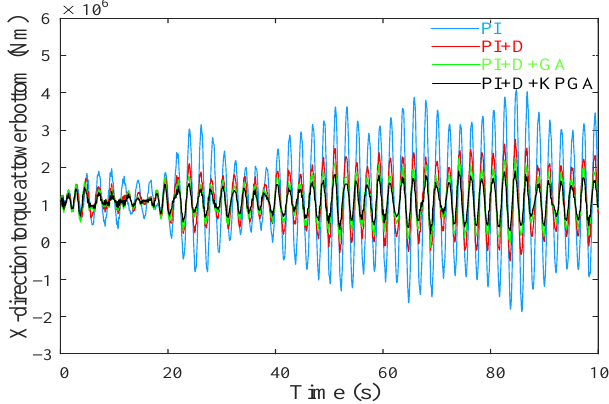
Figure 18. Change curve of x-direction torque for the tower bottom.